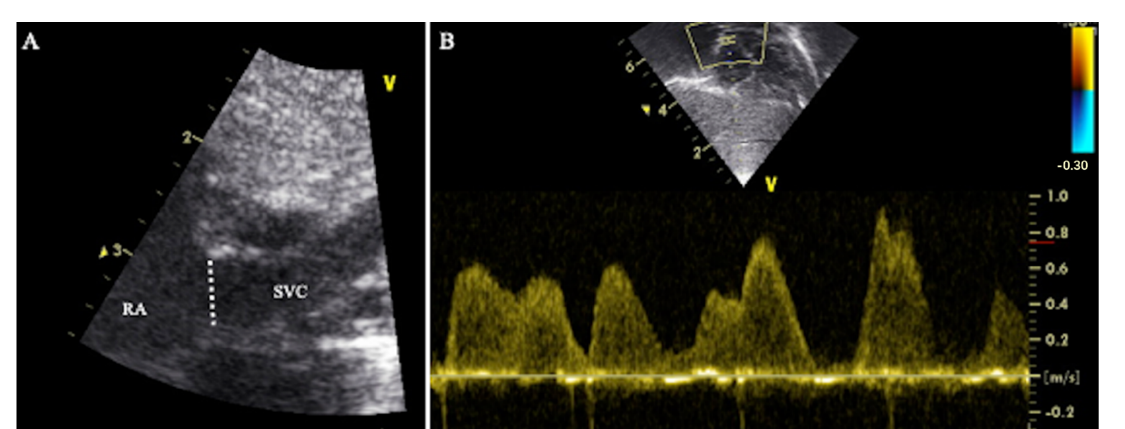
Figure 1. Traditional technique of SVC flow assessment (Method 1). ( A ) High-definition zoom on the SVC-right atrium junction from a modified parasternal long axis view. The dotted line repre- sents the SVC diameter. ( B ) Doppler profile of blood flow velocity in the SVC. The sample gate of pulsed wave Doppler was placed at the SVC-right atrium junction from a subcostal view . RA = right atrium, SVC = superior vena cava.